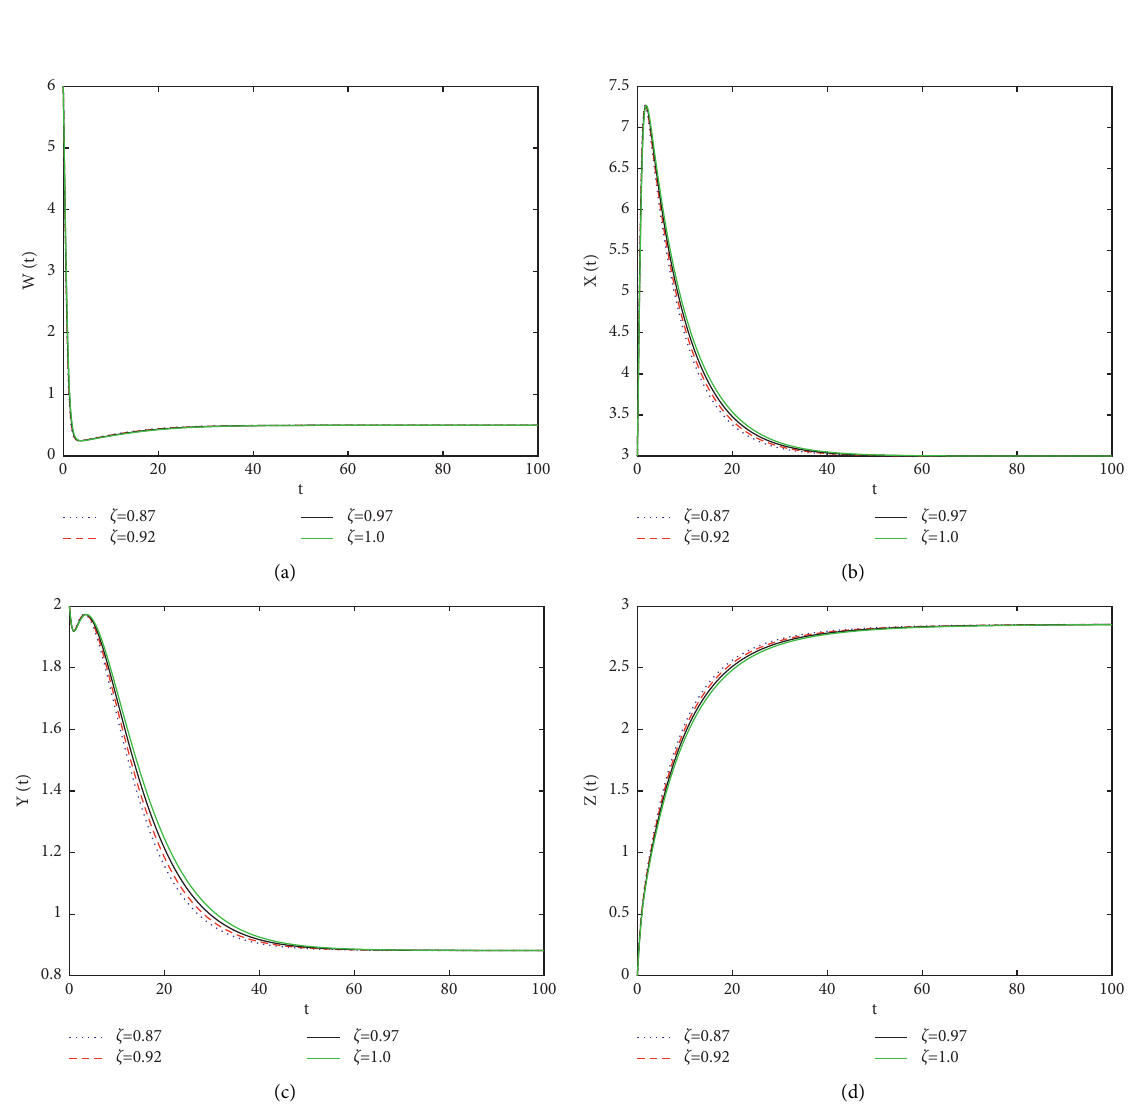
Figure 1: Graphical representation of the series solution of ( W ( t ) , X ( t ) , Y ( t ) , Z ( t )) of the proposed system (2) for various arbitrary orders. (a) W(t): susceptible population. (b) X(t): acutely infected population. (c) Y(t): chronically infected population. (d) Z(t): recovered